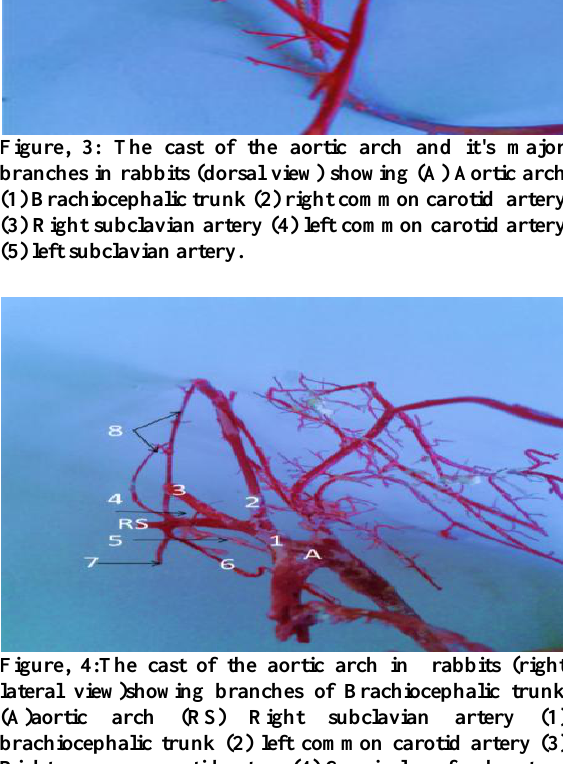
Table, 1: Mean diameter and thickness (µm) of the intimal, medial, adventitial layers and thickness of the wall of aortic arch in local breed rabbits.